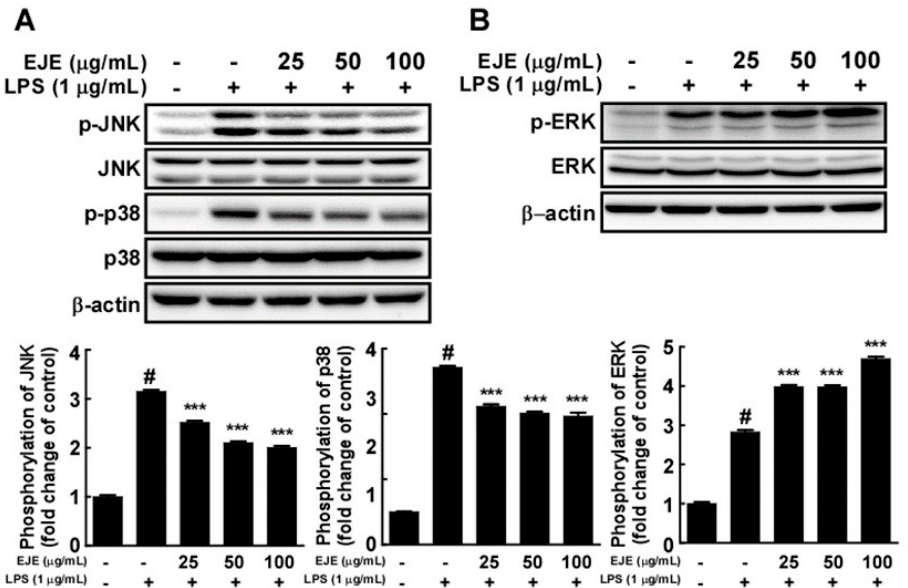
Figure 3. Effect of EJE on the LPS ‐ induced mitogen ‐ activated protein kinase (MAPK) signaling pathway in BV2 cells. (A) At 30 min after LPS treatment, EJE inhibited LPS ‐ induced phosphorylation of c ‐ Jun NH 2 terminal protein kinase (JNK) and p38 mitogen ‐ activated protein kinase (p38) in BV2 microglia. Protein expression was detected by Western blotting with specific antibodies. (B) Extracellular signal ‐ regulated kinase (ERK) was more heavily phosphorylated by treatment with EJE. Expression and phosphorylation were detected by Western blot with specific antibodies. Hash symbols (#) indicate a significant difference ( p < 0.001) between the control group and the group exposed to LPS alone; asterisks (* and ***) indicate significant differences ( p < 0.05 and p < 0.001, respectively) between groups co ‐ treated with LPS and EJE and the group exposed to LPS alone. In this and all the following Figures, data are presented as the mean ± SEM of three independent experiments.